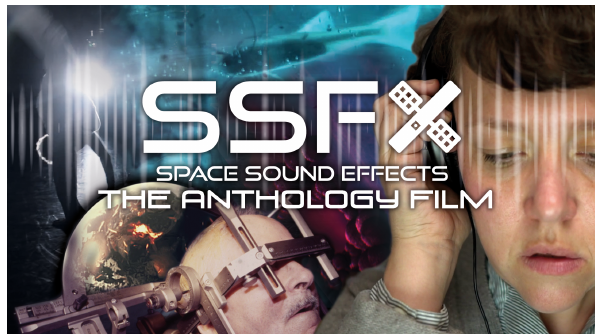
Figure 4. Anthology film poster composed of imagery from each of the selected